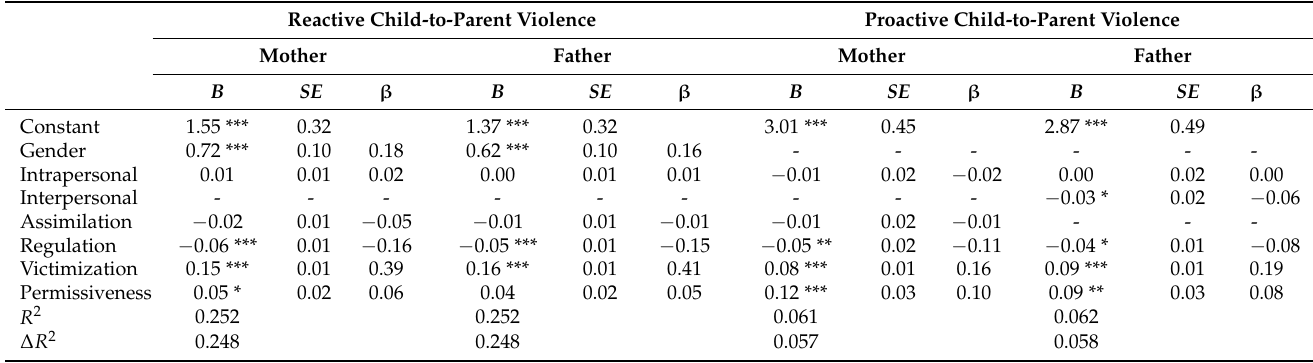
Table 5. Multiple linear regressions of the prediction of reactive and proactive child-to-parent violence by generalist